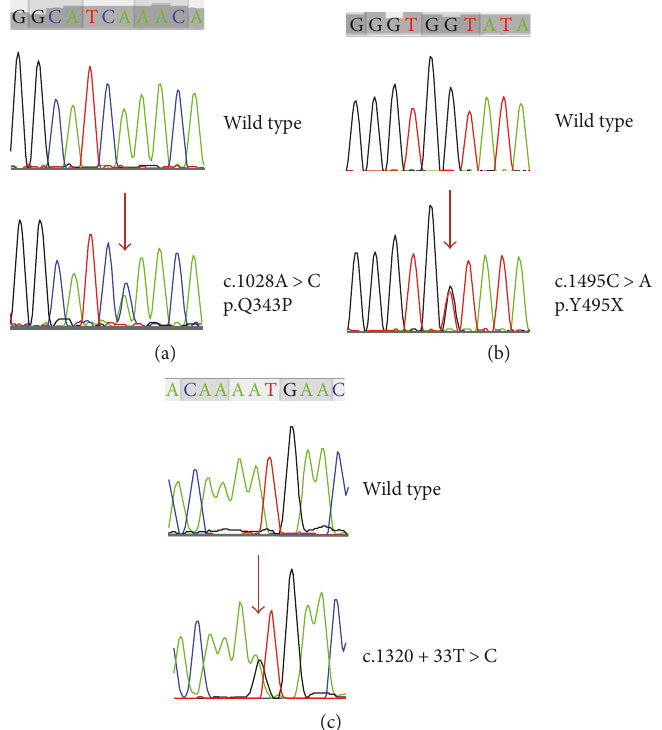
Figure 1: The novel SIAE rare variants identi fi ed in the patients of the study: (a) p.Q343P, (b) p.Y495X, and (c) c.1320+33T >